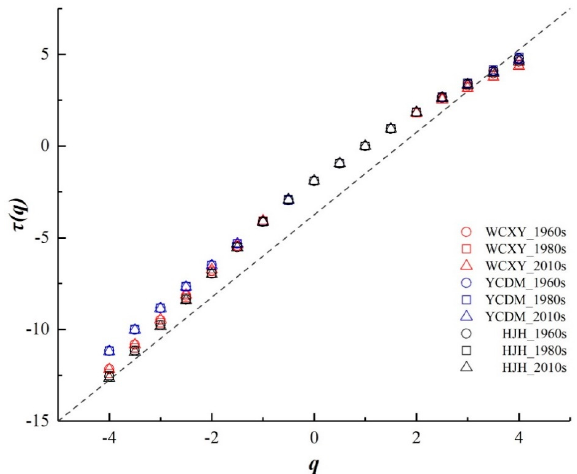
Figure 4. The relationship between mass exponent τ ( q ) and moment orders q of Hangjiahu (HJH), Wuchengxiyu (WCXY), and Yangchengdianmao (YCDM) in the 1960s, 1980s, and 2010s.